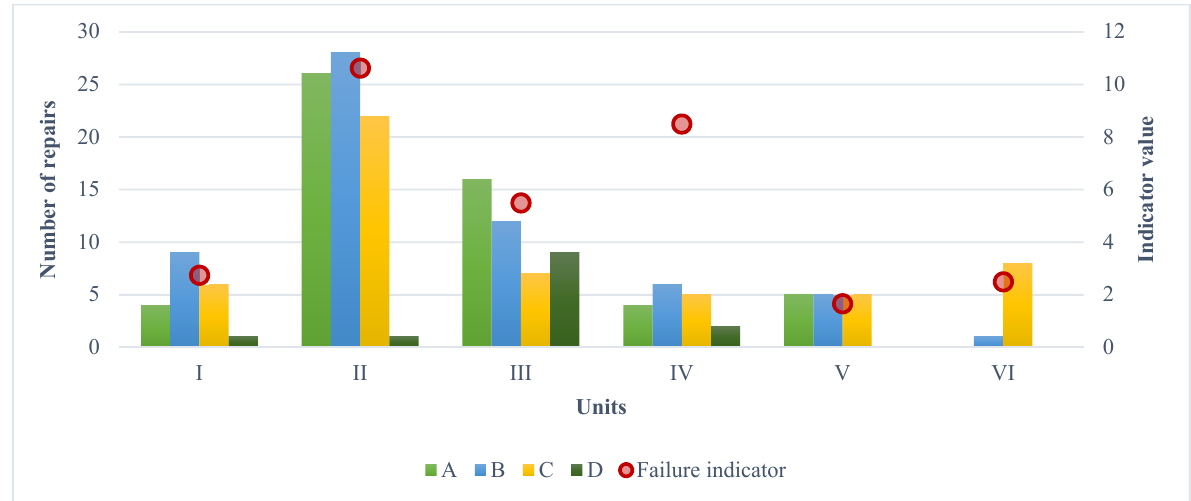
Figure 13. Number of repairs for the elements A, B, C, and D, and the daily failure indicator for the individual mining units in the mine.